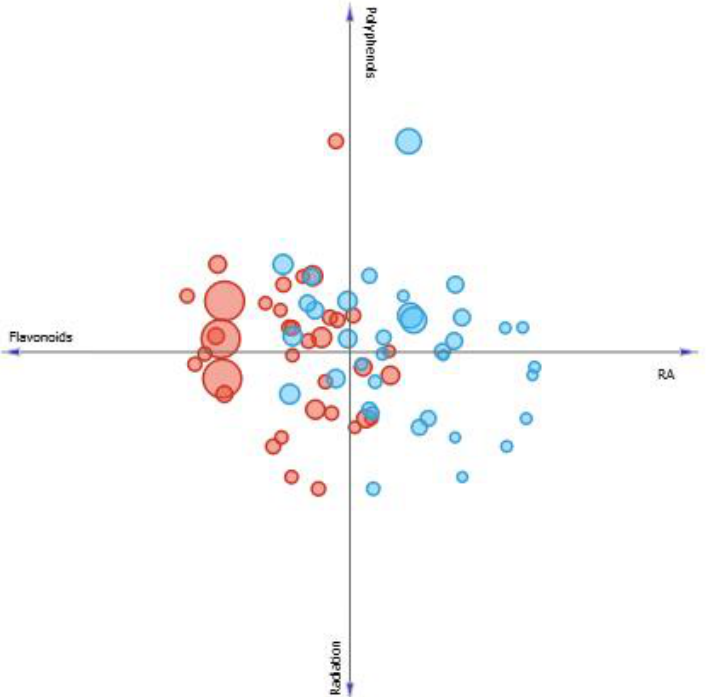
Figure 9. Linear projection correlating the content of phenolics, flavonoids, and rosmarinic acid of M. villosa (blue circles) and P. amboinicus (red circles) to solar radiation. Circles size corresponds to a greater or lesser EC 50 value found.